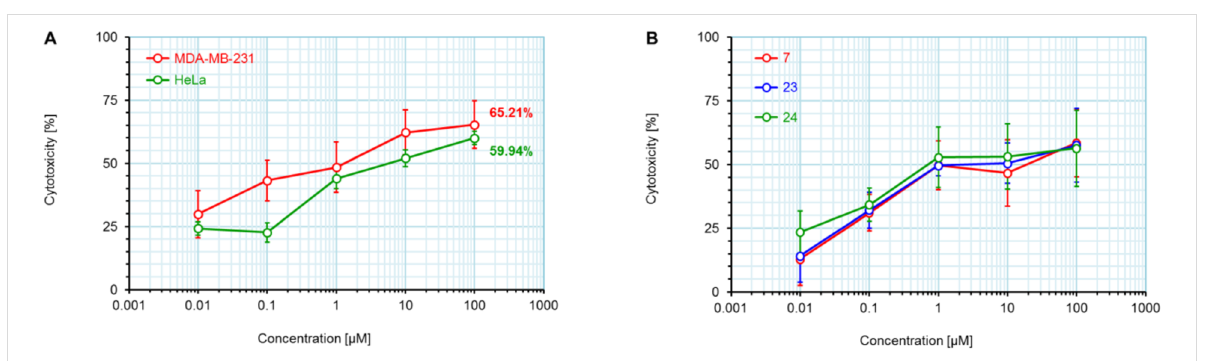
Figure 4: Dose dependence of the cytotoxicity of tested compounds on treated cell lines. All compounds were tested in the concentration range 0.1–100 μ M. A) Cytotoxicity of compound 3 against MDA-MB-231 and HeLa cell lines. B) Cytotoxicity of compounds 7 , 23 , and 24 on breast cancer cell line